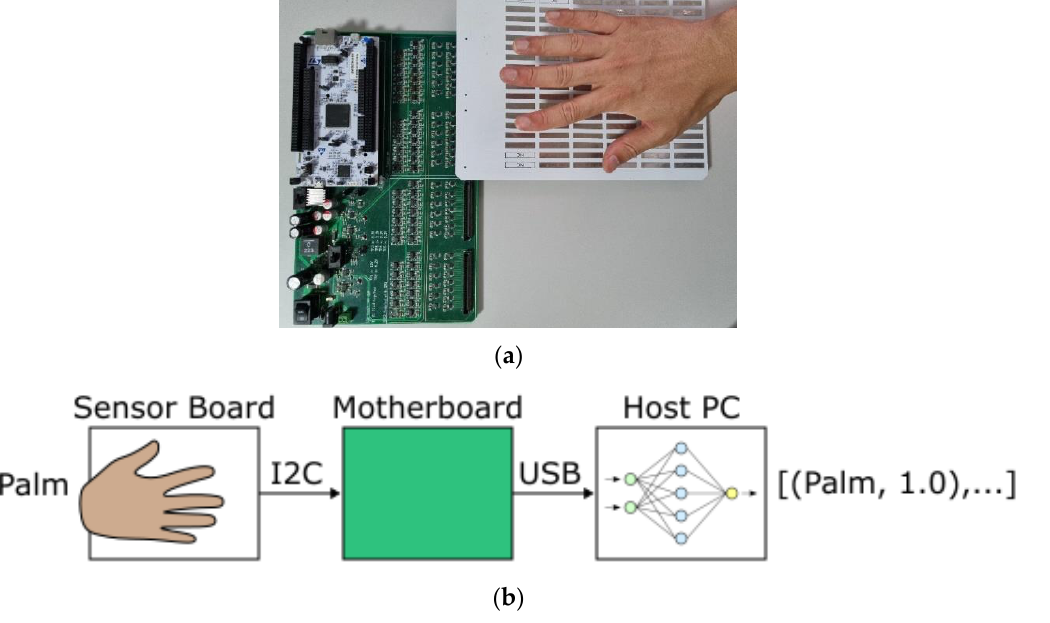
Figure 1. The proposed system: ( a ) Motherboard and connected Sensor Board; ( b ) Gesture recognition pipeline.